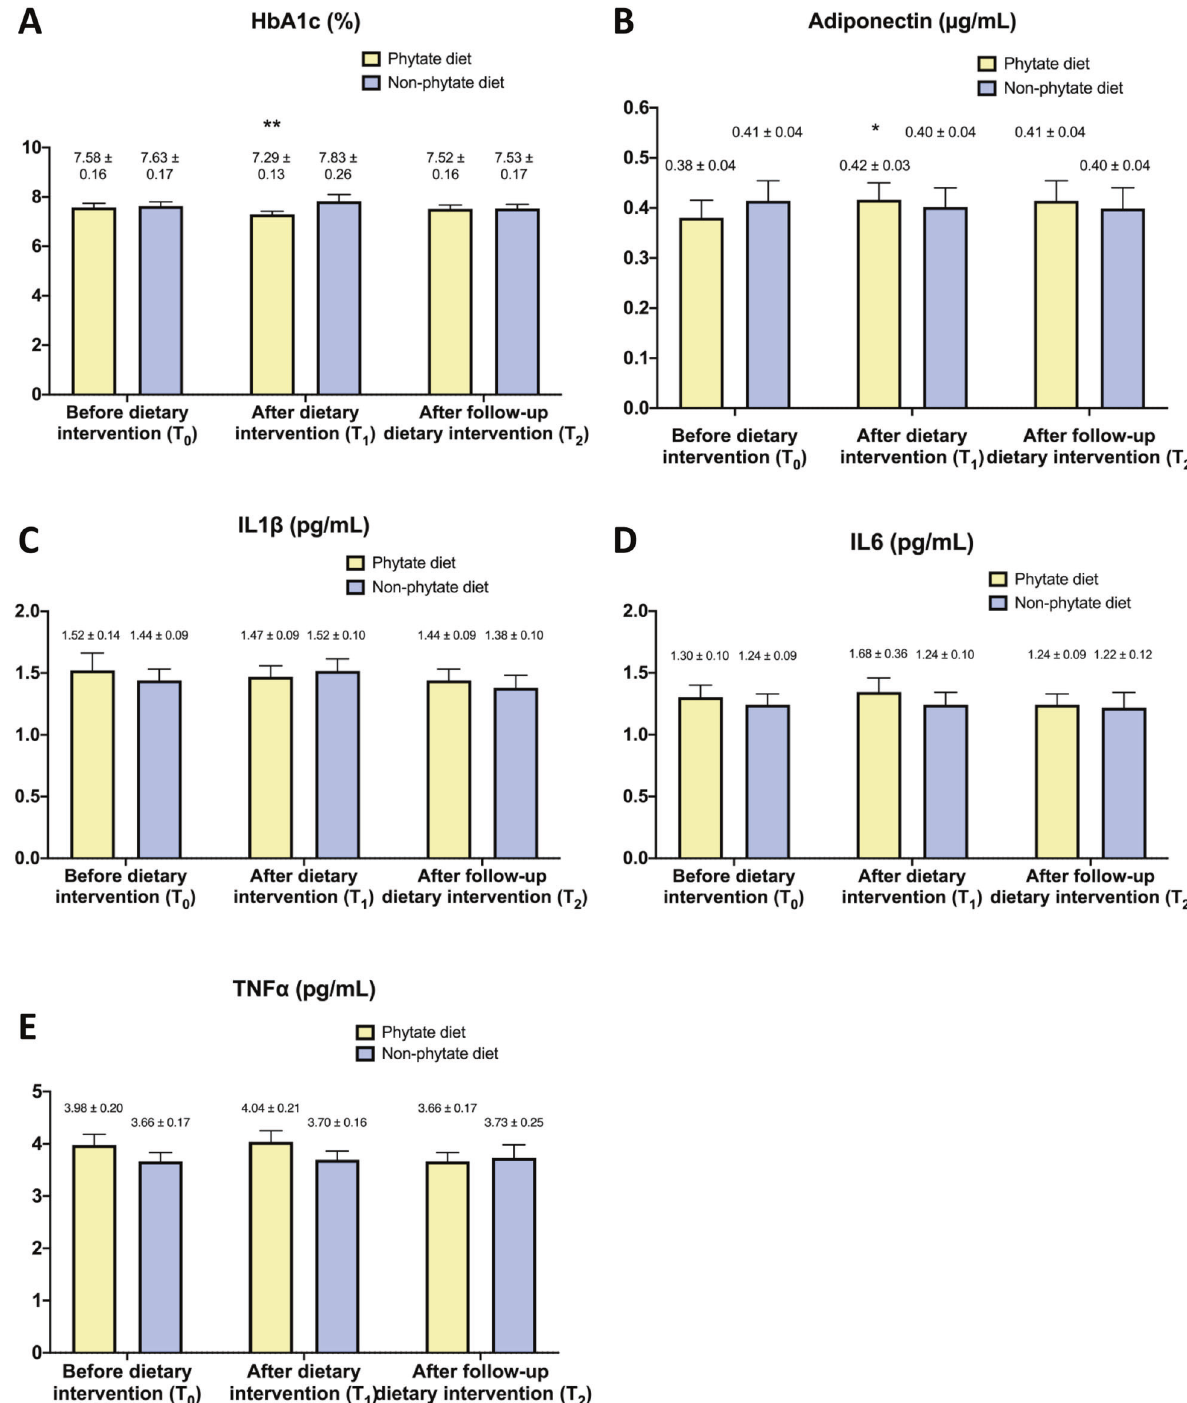
Fig. 2 Effect of phytate on HbA1c, Adiponectin, IL1beta, IL6 and TNF-alpha. Effect of phytate diet on serum levels of HbA1c ( A ), Adiponectin ( B ), IL1 ( C ), IL-6 ( D ), and TNF-alpha ( E ). Values are expressed as means and SEM. Intragroup differences (T0 vs. T1, T1 vs. T2) were assessed using a paired-sample Wilcoxon signed-rank test or T-paired test (** P value <0.05 for T1 vs. T0 & T1 vs.T2, * P value <0.05 for T1 vs. T0). Intergroup differences (phytate diet vs. non-phytate diet) were assessed using the Mann – Whitney U test or T student for the before-dietary intervention group, and analysis of covariance after adjusting for baseline levels for after and follow-up dietary intervention groups (#). Benjamini – Hochberg procedure was used to correct for the false discovery